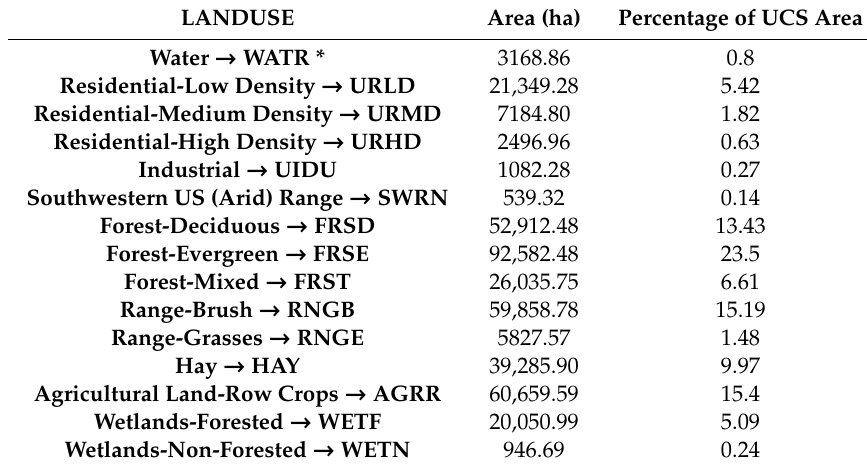
Table 1. National Land Cover Database (NLCD) land cover types and their coverage of the Upper Choctawhatchee Subbasin (UCS)